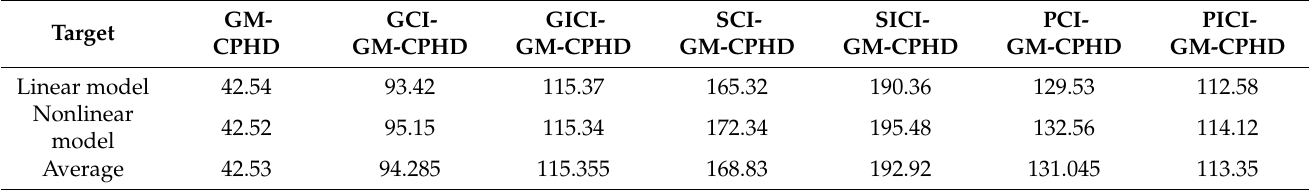
Table 4. Comparison results of algorithm running time.